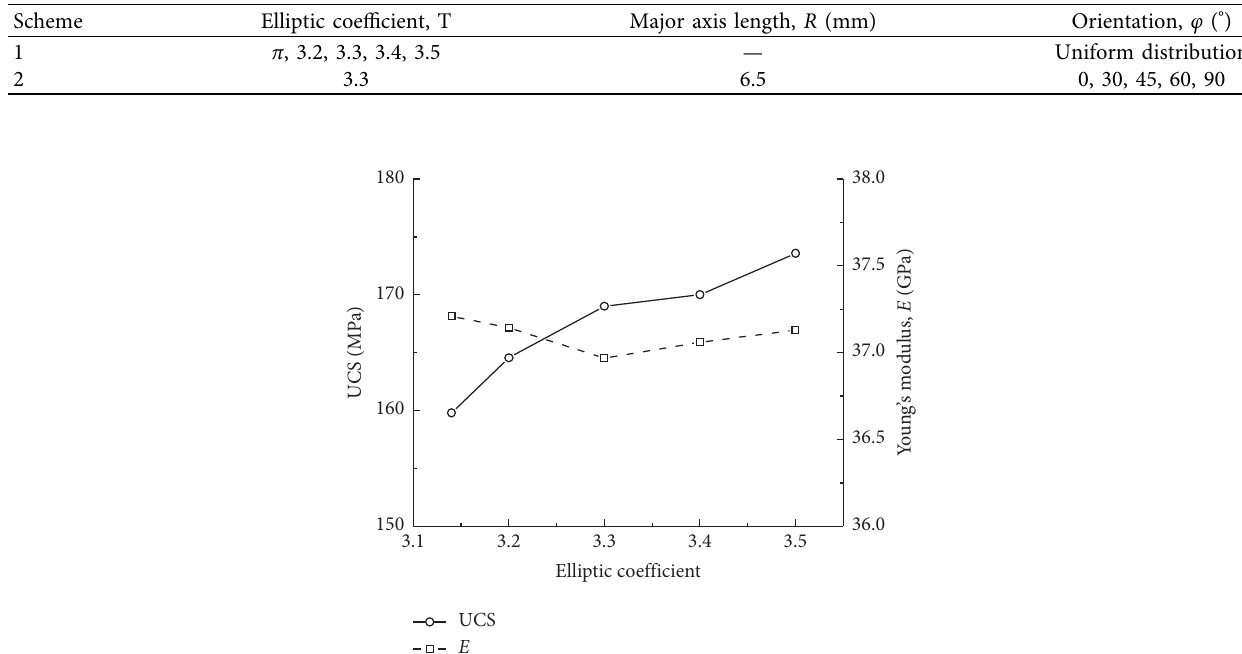
Table 3: Analysis models and parameter settings.